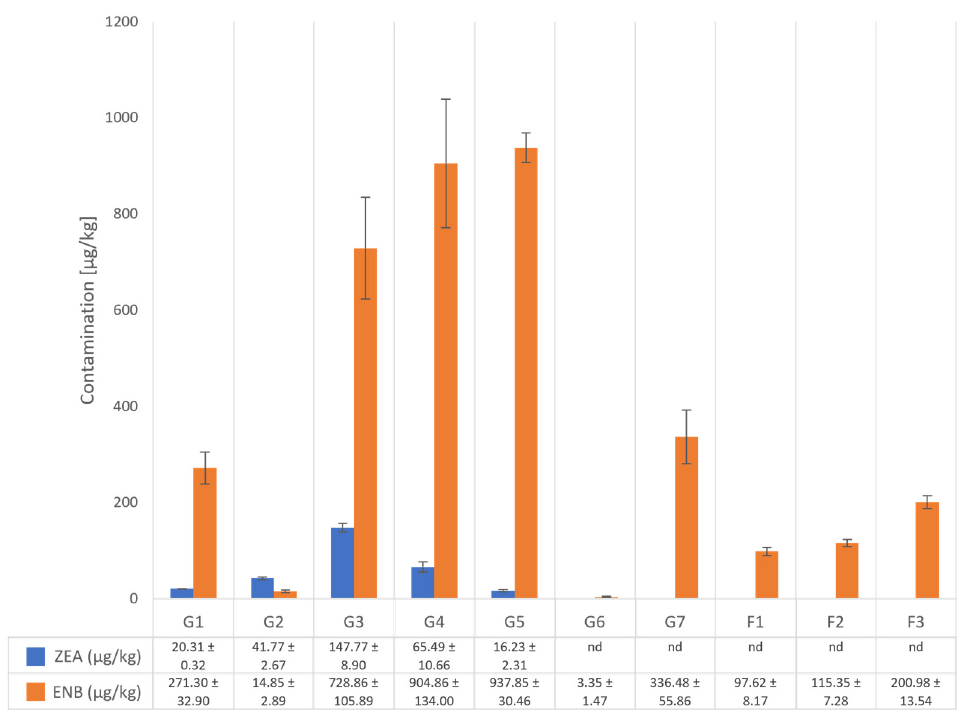
Figure 1. Amount of zearalenone (ZEA) and enniatin B (ENB) in wheat grains (G samples) and wheat flours (F samples) expressed as µg/kg; nd: not detected.